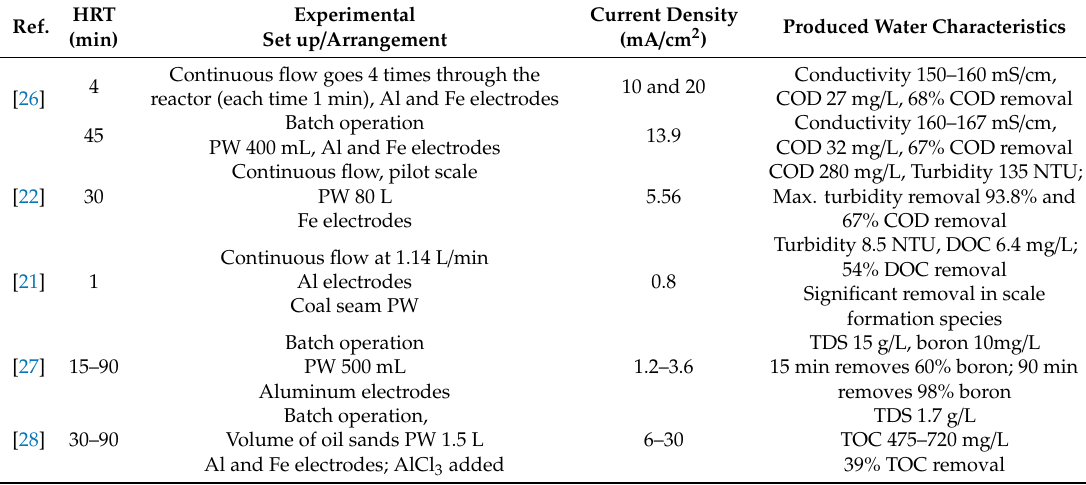
Table 1. Electrocoagulation technologies applied in produced water treatment: design parameters. HRT Ref.